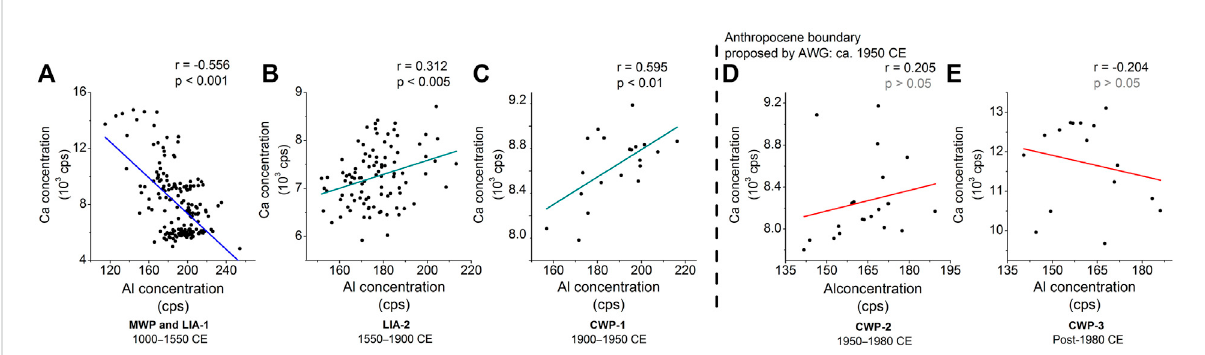
FIGURE 11 The Pearson correlation coef fi cient r and signi fi cance level p -value between Al and Ca concentrations in (A) the Medieval Warming Period (MWP) and Little Ice Age-1 (LIA-1), (B) Little Ice Age-2 (LIA-2), and (C – E) three stages of the Current Warming Period (CWP-1, CWP-2, CWP-3) of Gonghai Lake. The dashed line indicates the onset of the Anthropocene proposed by the